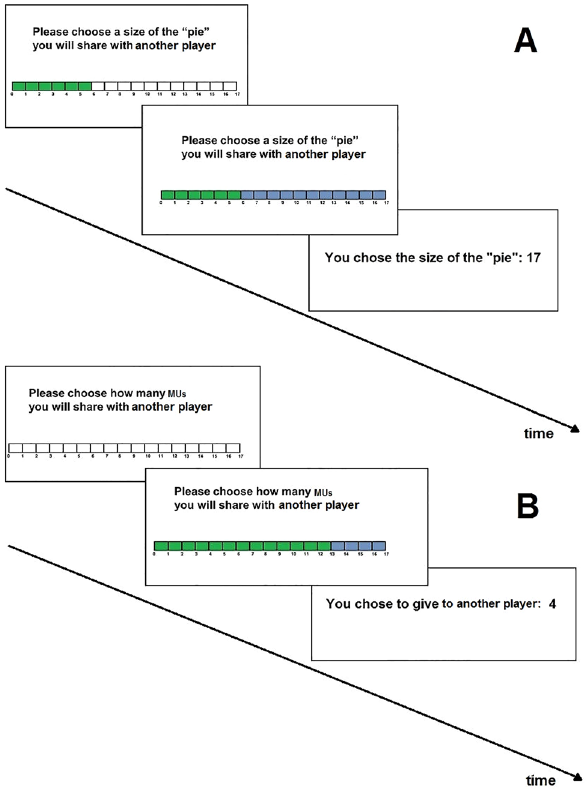
Figure 1. The timelines of the sample trials in ( A ) the generosity game and ( B ) dictator game. Blue indicates the size of the pie (generosity game) or the number of MUs shared with player 2 (dictator game). Green indicates player 1’s fixed share of the pie (generosity game) or the number of MUs kept by player 1 (dictator game).